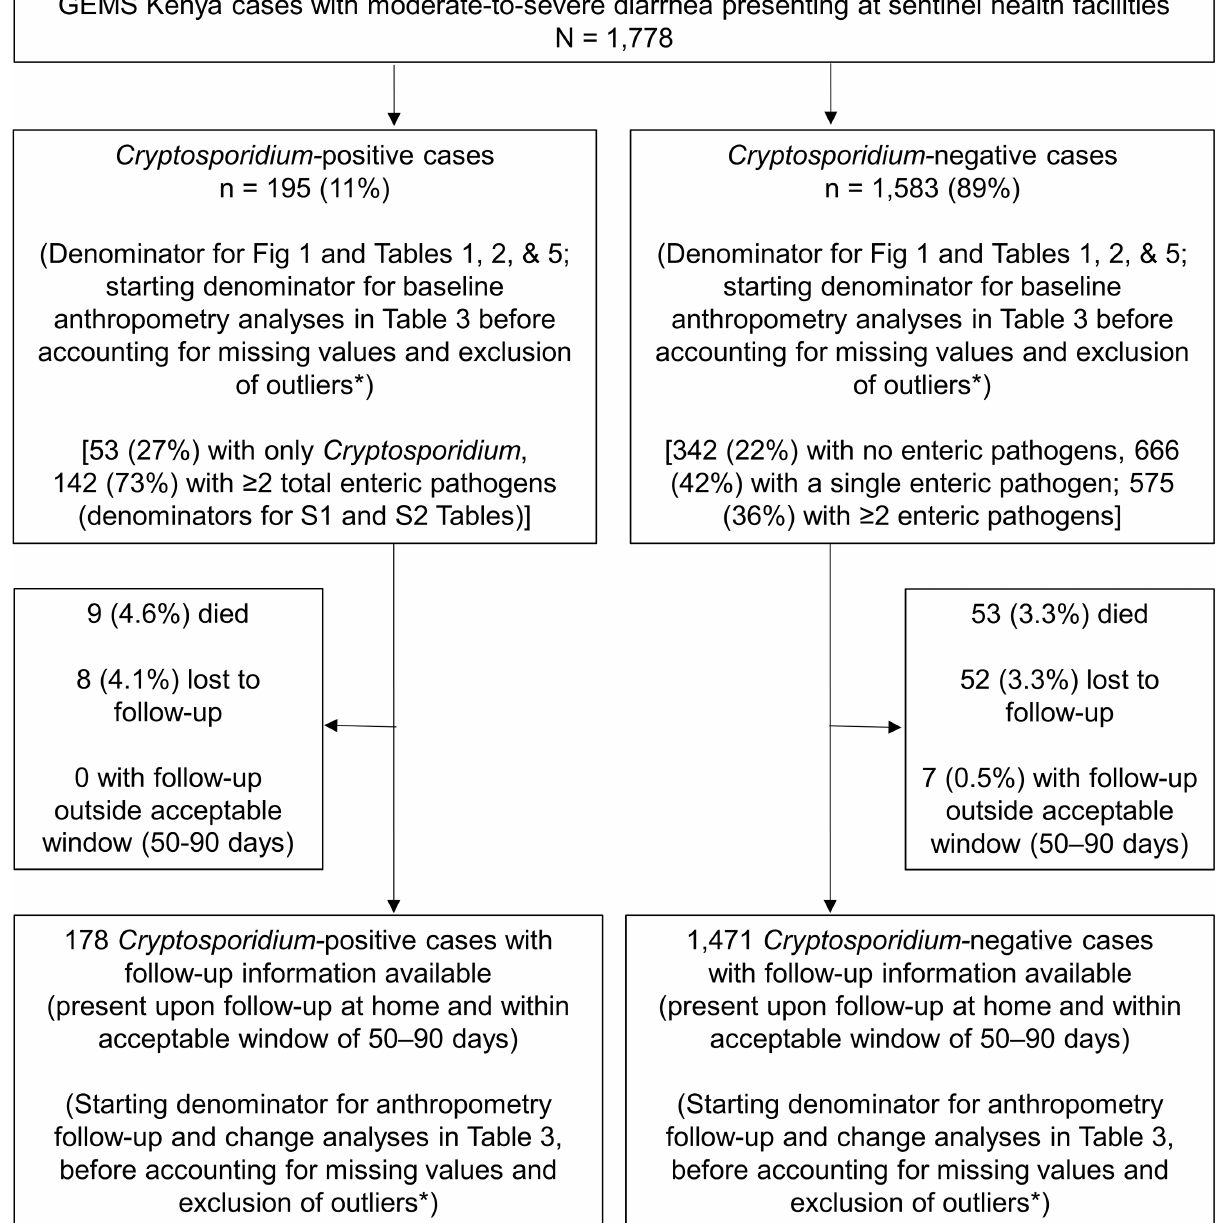
Fig 2. GEMS-Kenya cases (N = 1,778) with Cryptosporidium status and follow-up status/anthropometric measurements, western Kenya, 2008– 2012.